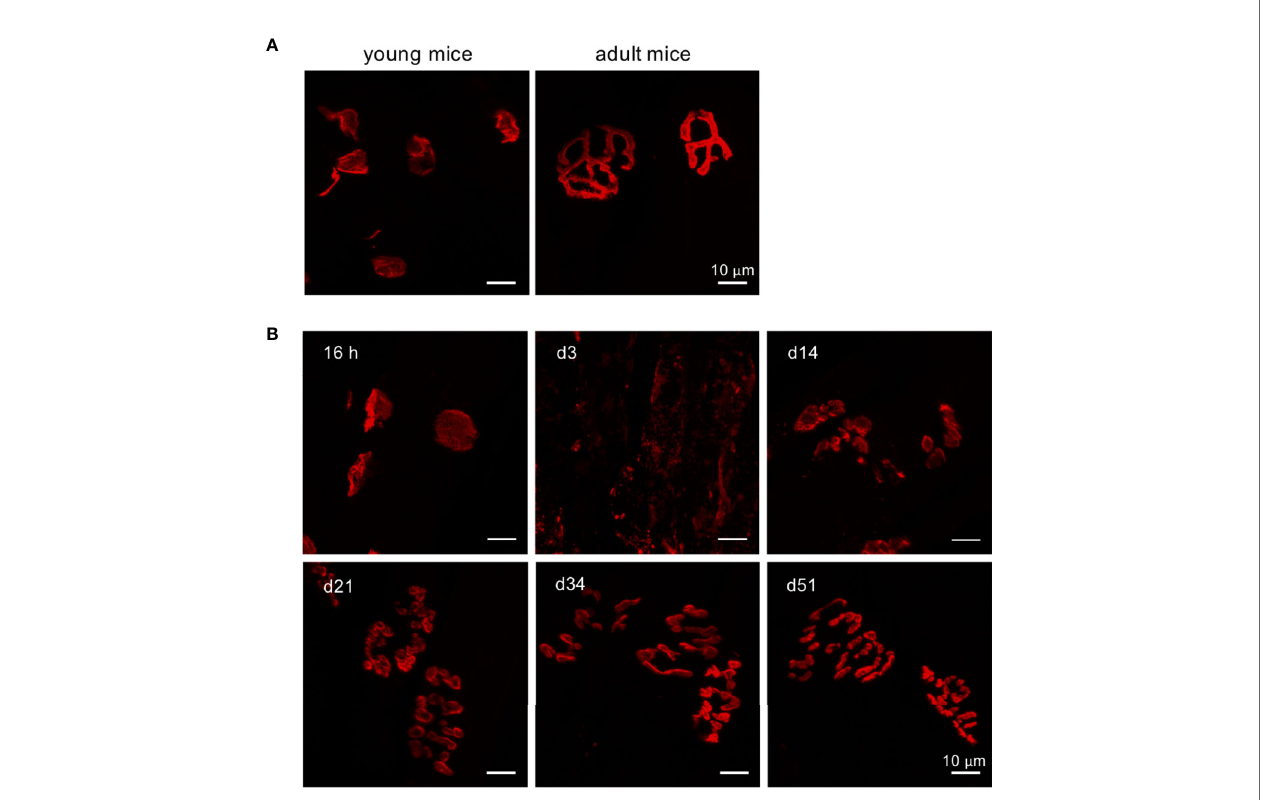
FIGURE 4 | Defects in postsynaptic NMJ structure in the gastrocnemius muscle of EV71-infected mice. (A, B) Cryosections of gastrocnemius muscle from sham- infected young mice (P15), sham-infected adult (P34) (A) , or EV71-infected mice at 16 h (score = 0), day 3 (score = 2), day 14 (score = 1), day 21 (score = 0.5), day 34 (score = 0.5), and day 51 (score = 0) post-infection (B) were stained with tetramethylrhodamine a -BTX and observed under LSM700 confocal